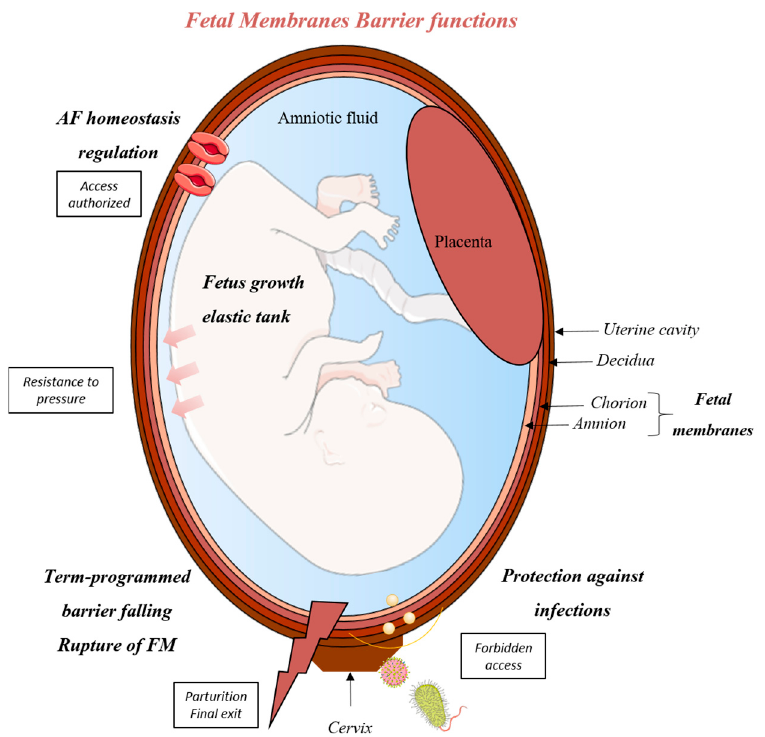
Figure 1. Physiological functions of the FM barrier. FMs are a nine-month organ required for the progress of the pregnancy. Indeed, they exercise different essential functions. First, they constitute an adjustable tank resisting internal and external pressure where the fetus can move and grow. FM also allows the amniotic fluid (AF) to achieve homeostasis by letting ions, water and other compounds pass, notably through aquaporins. On the other hand, they physically and chemically limit the ascension of microbial agents. Finally, they are implicated in parturition by their planned and controlled rupture at term. SMART Servier Medical Art device was used from the creation of the figure.